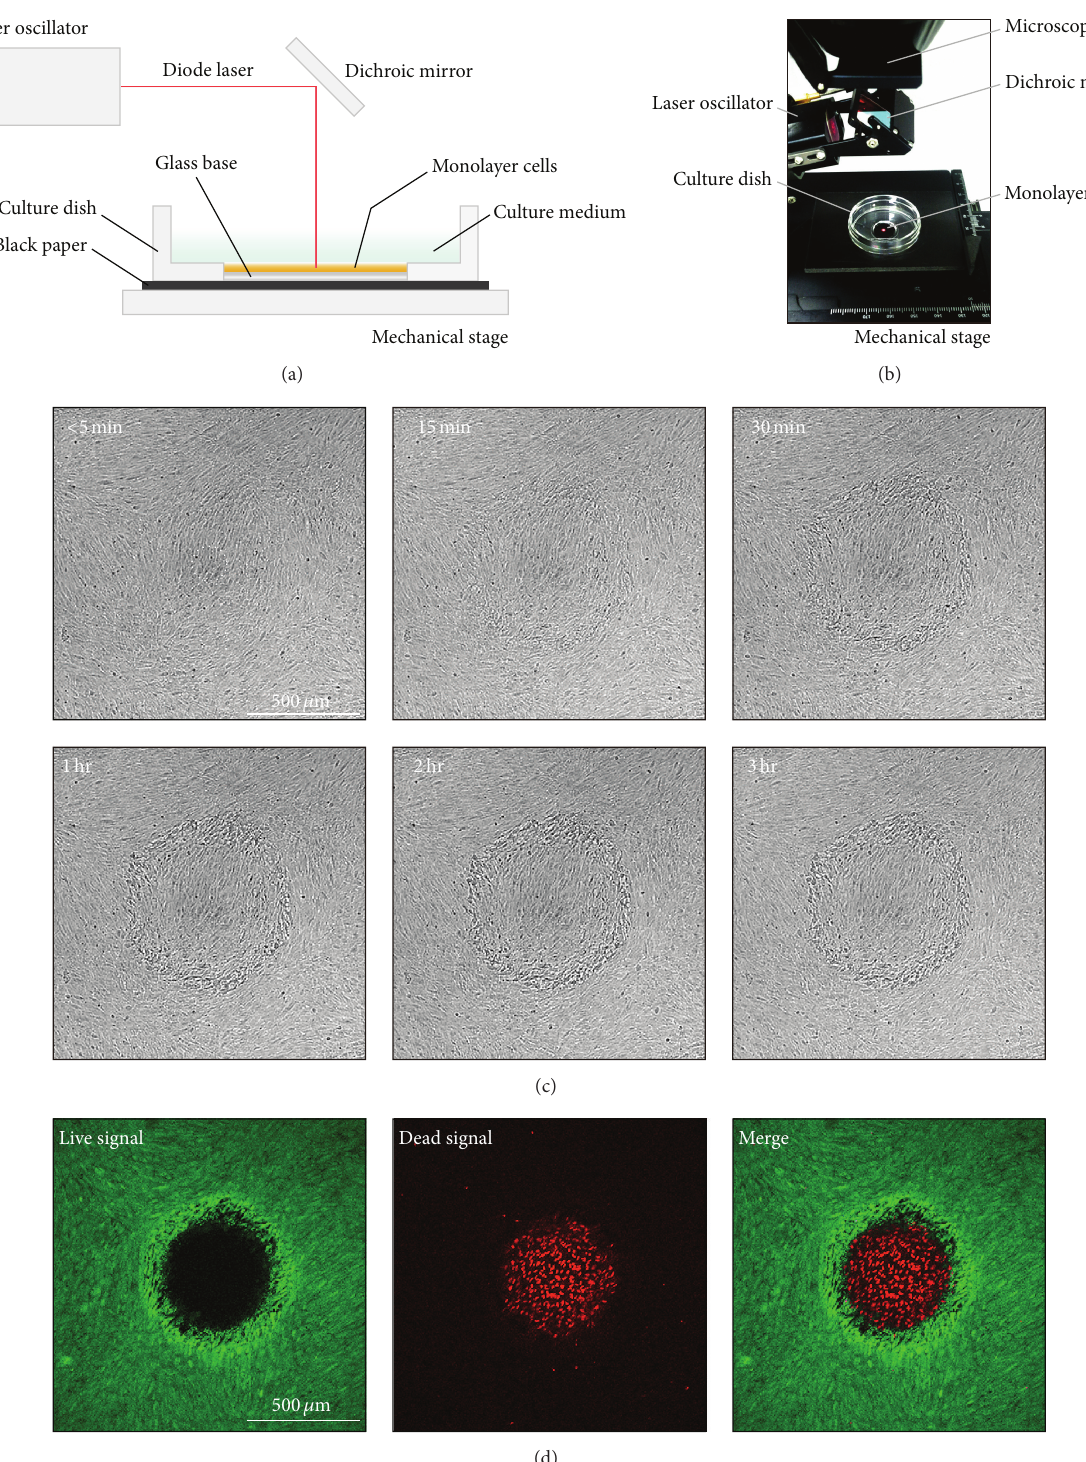
Figure 1: Experimental setup for laser irradiation of cultured cell layers. (a, b) A diode laser beam passed through a dichroic mirror to perpendicularly irradiate a full confluent cultured cell layer on a glass-based dish. To avoid blocking diode laser light, a phenol-red-free culture medium was used. (c) Confocal microscopy bright-field images of the irradiated cell layer. Spots were made using the continuous- wave mode with a power of 250 mW, duration of 500 ms, and spot size of 200 𝜇 m. The white dotted circle indicates the laser irradiation site. A video is also available (see Supplementary Material 1). (d) Two hours after laser irradiation (using the laser settings described in (c)), cell viability was assessed using LIVE/DEAD cell imaging reagents. Live cells were stained green, and dead cells were stained red. Fluorescent images were captured with confocal microscopy (projected images). Cells within the laser spot were dead, but cell groups forming the sparse annular intercellular spaces observed in the bright-field images were